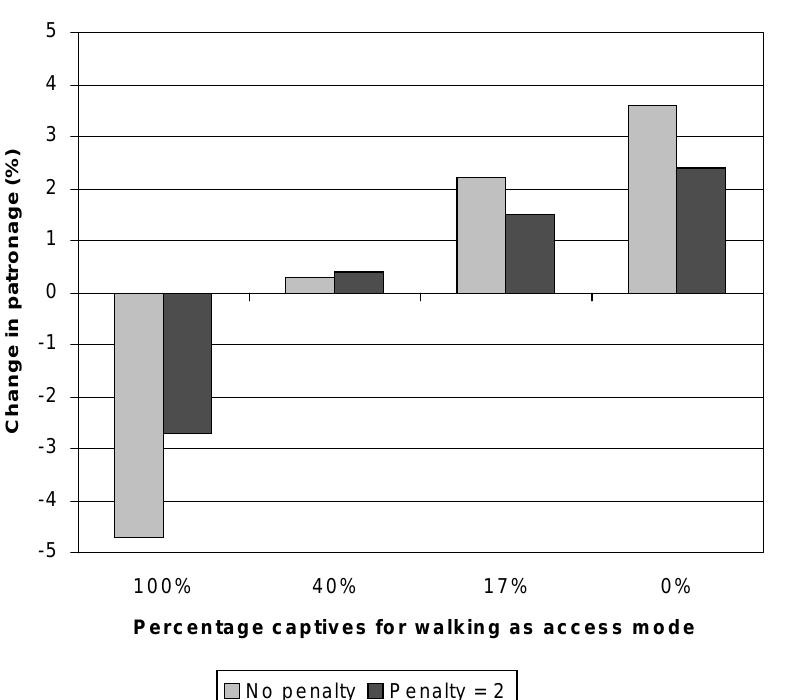
Figure 6. Net impact on demand level of a multimodal network structure for four access